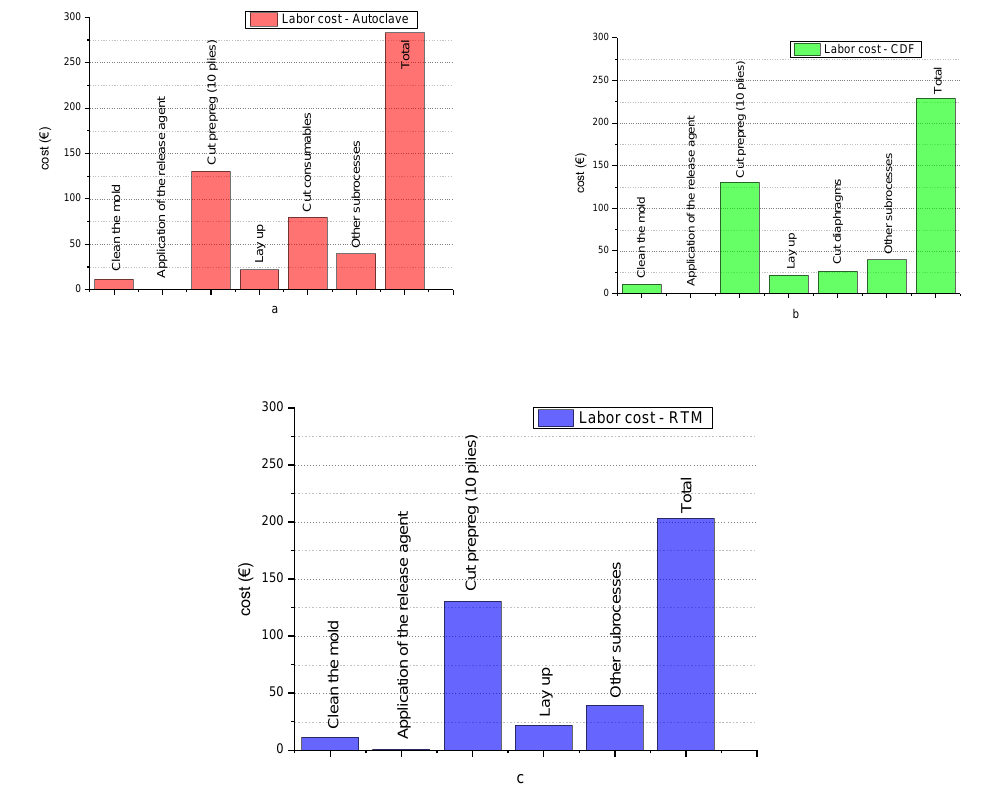
Figure 8. Labor cost breakdown structure for ( a ) Autoclave, ( b ) CDF, ( c ) RTM.